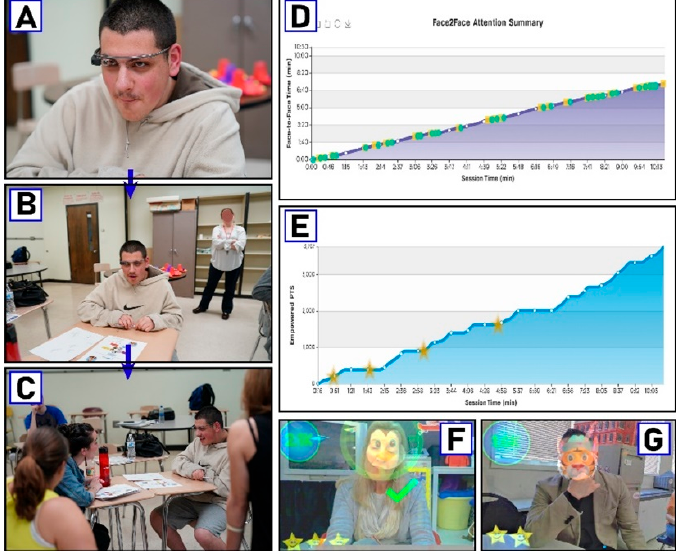
Figure 2. Overview of Empowered Brain as related to attention-deficit / hyperactivity disorder (ADHD) symptom stratification. ( A – C ) Non-study student wears Empowered Brain smartglasses and